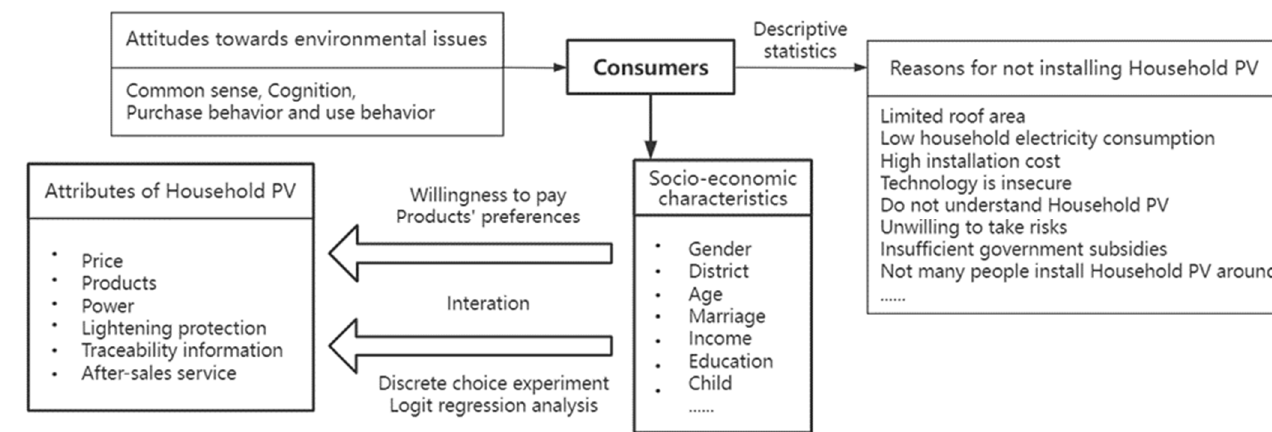
Figure 1. Research framework.